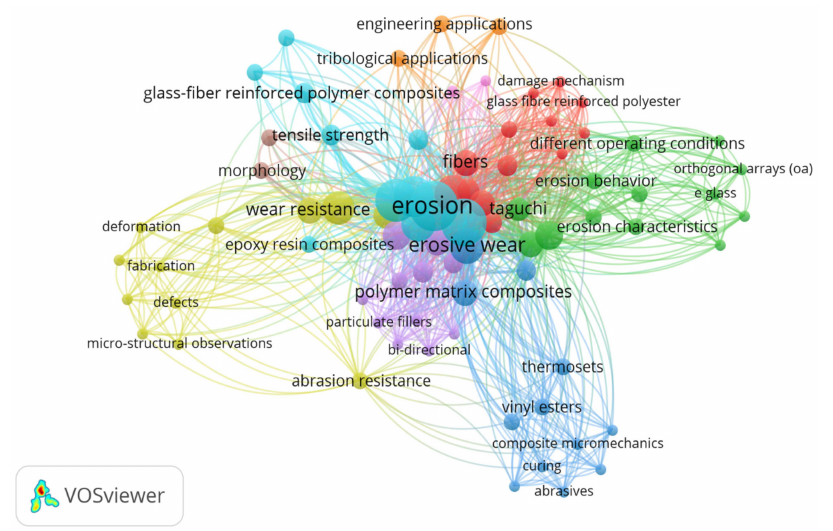
Figure 1. Bibliometrics visualisation overview of technology-based progressions on the erosion- behaviour of composites obtained from the various thermoset-resins (epoxy, polyester, and vinyl- ester) for a multitude of